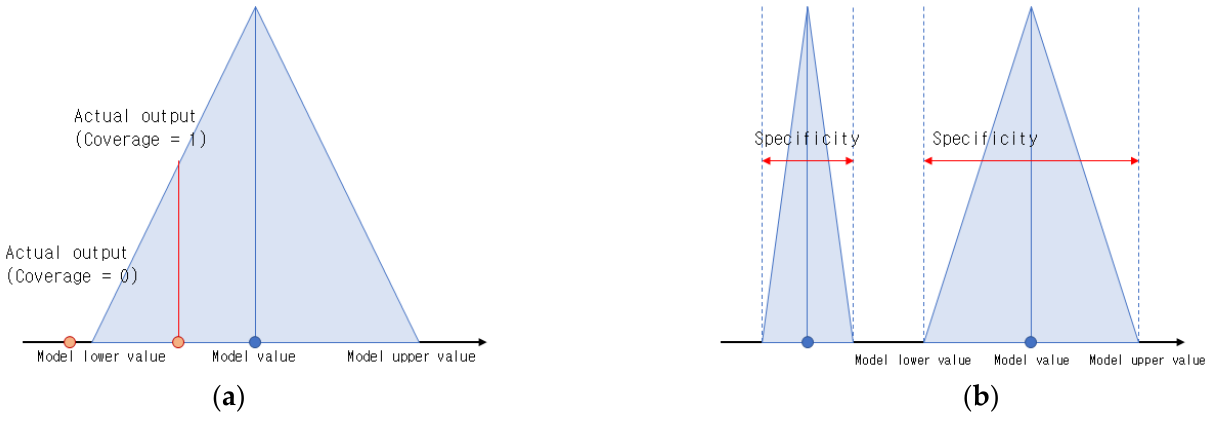
Figure 4. Concepts of coverage and specificity for creating rational IGs: ( a ) concept of coverage; ( b ) concept of specificity.